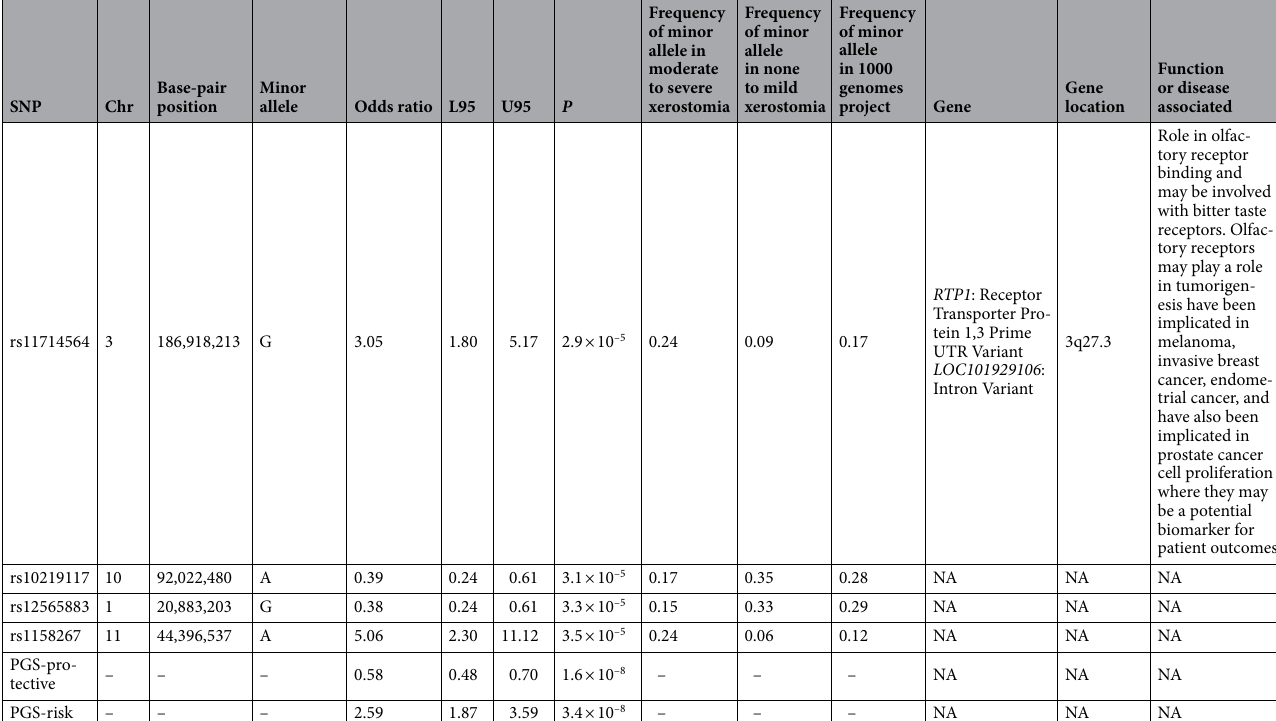
Table 2. Association results of leading SNPs with P ≤ 1 × 10 −5 associated with moderate to severe xerostomia